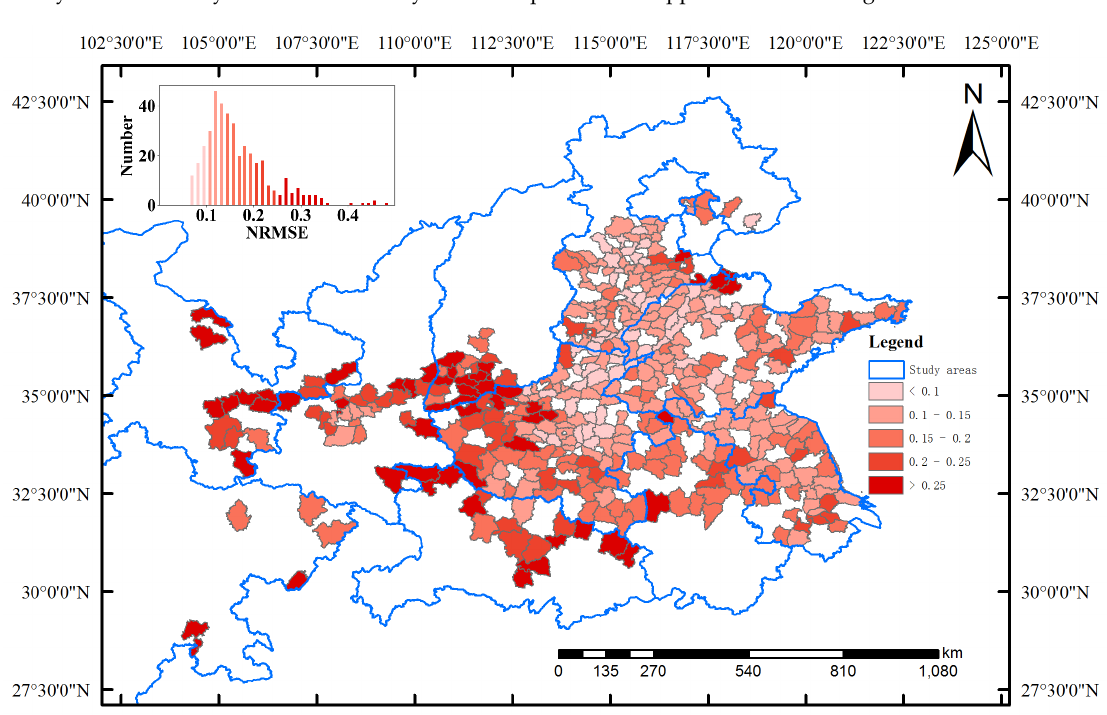
Figure 6. Spatial distribution of the Normalized Root Mean Square Error (NRMSE) calculated from the predicted yields of all the years for each county. The inset panel in the upper left is the histogram of